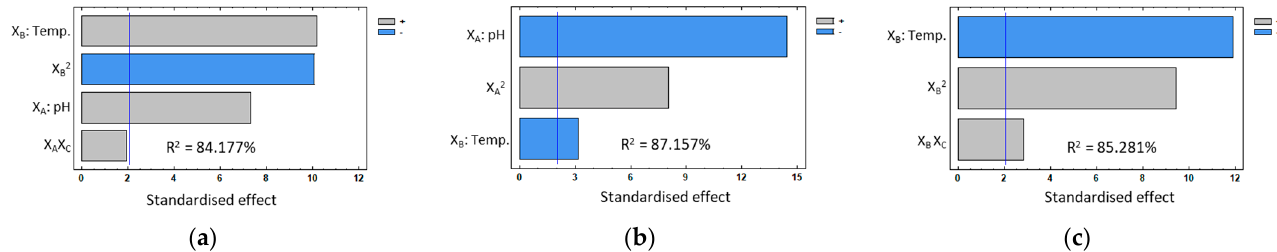
Figure 3. Analysis of the effects of the Box–Behnken factorial design. Pareto charts with standardised effects of three experimental factors, in decreasing order of importance (in absolute value) for the three responses: protein concentration ( a ); ORAC ( b ); and iACE ( c ). The vertical blue lines represent the threshold of significance ( p = 0.05) for 32 degrees of freedom.